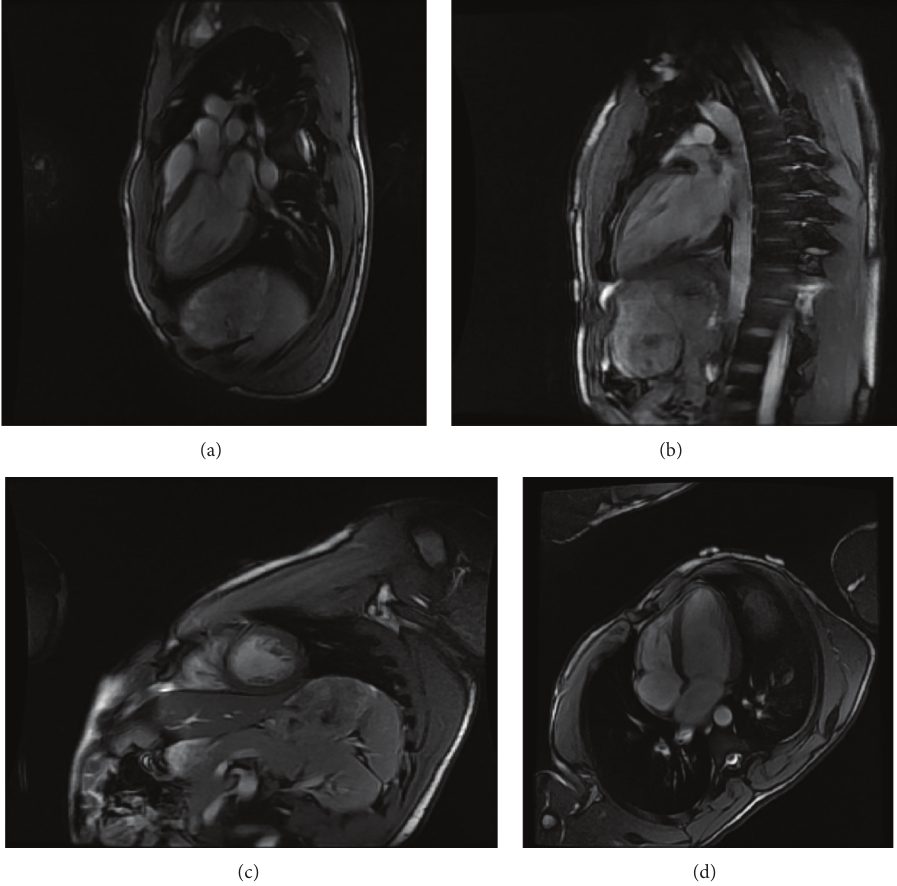
Figure 4: Cardiac MRI showing extensive apical and mid cavity obliteration of the papillary muscles and large trabeculations and intertrabeculation recesses in the left ventricle (a): three chamber image; (b): two chamber image; (c) short axis image; (d) four chamber